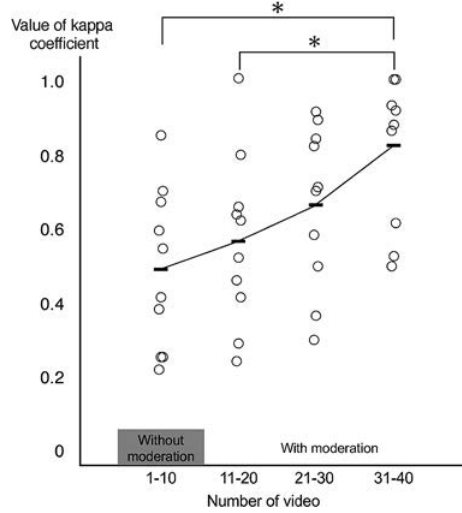
Figure 1 Kappa coefficients between the two raters for all 40 videos. The line plot shows the average value for each set of 10 videos; the first 10 videos were evaluated without